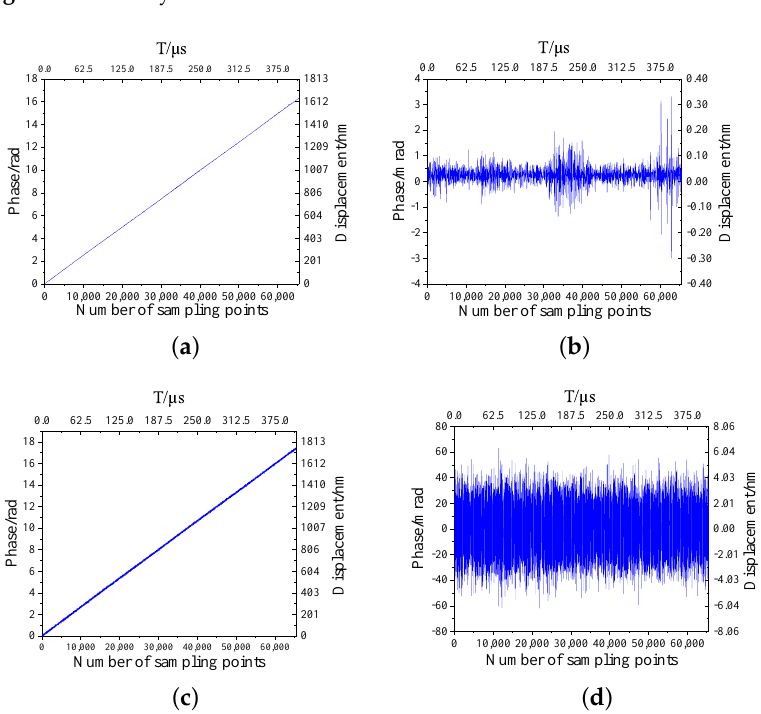
Figure 21. Phase and phase increments with and without dynamic filter for 1 mm/s velocity motion. ( a ) 1 mm/s phase with dynamic filter. ( b ) 1 mm/s phase increment with dynamic filter. ( c ) 1 mm/s phase without dynamic filter. ( d ) 1 mm/s phase increment without dynamic